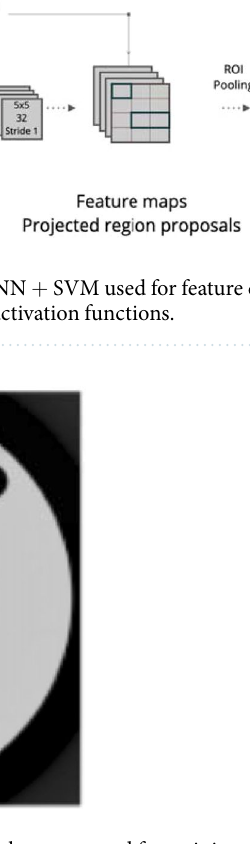
Figure 11. An example of simulated phantoms used for training of